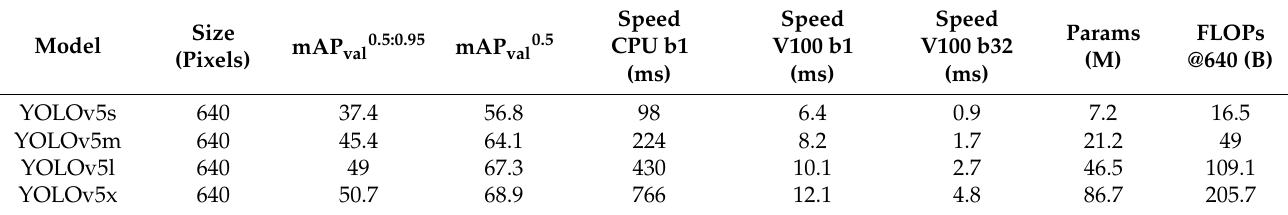
Table 1. Parameters of different YOLOv5 models